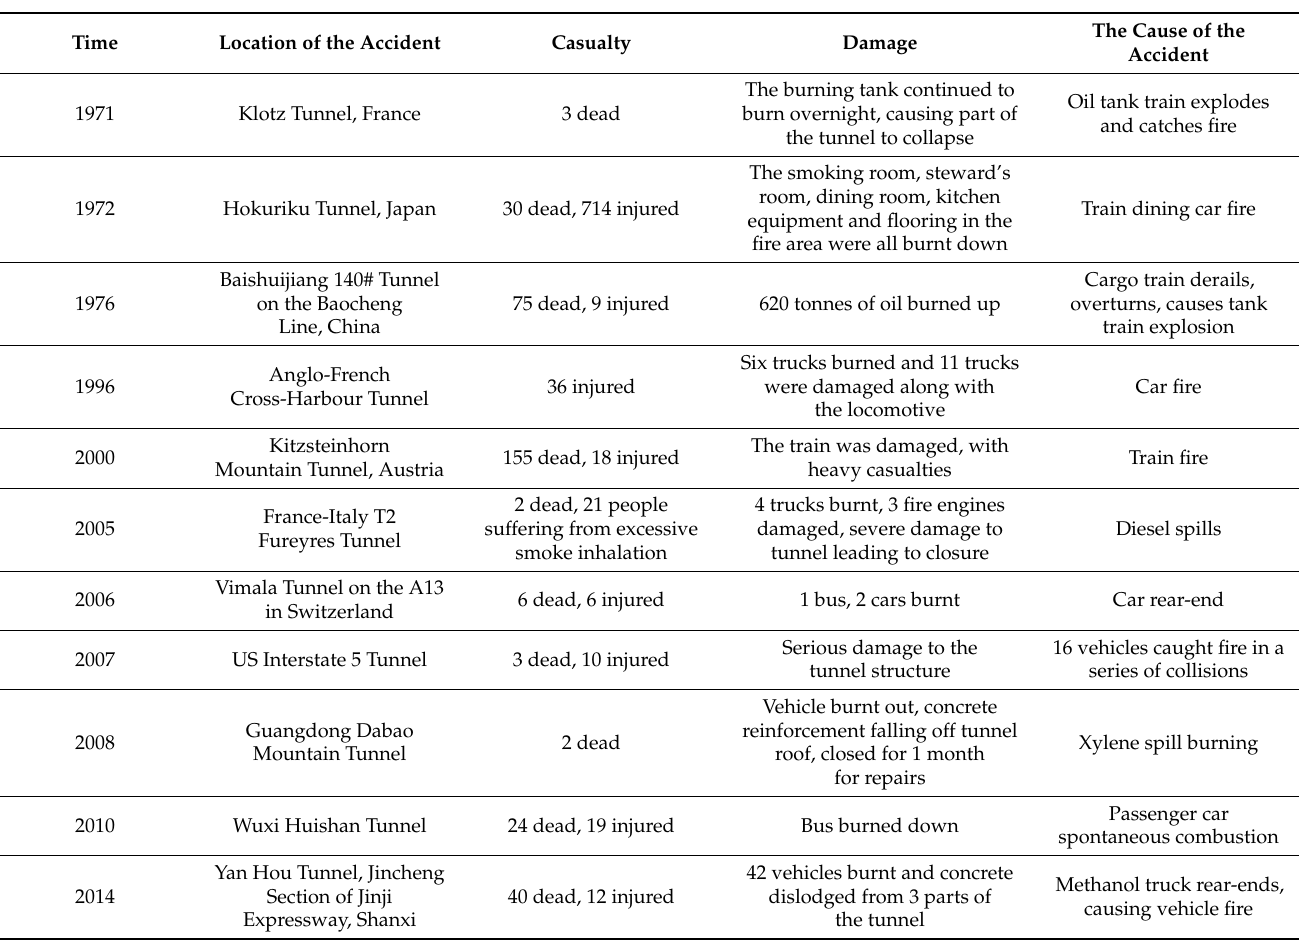
Table 1. Statistics on fire incidents in